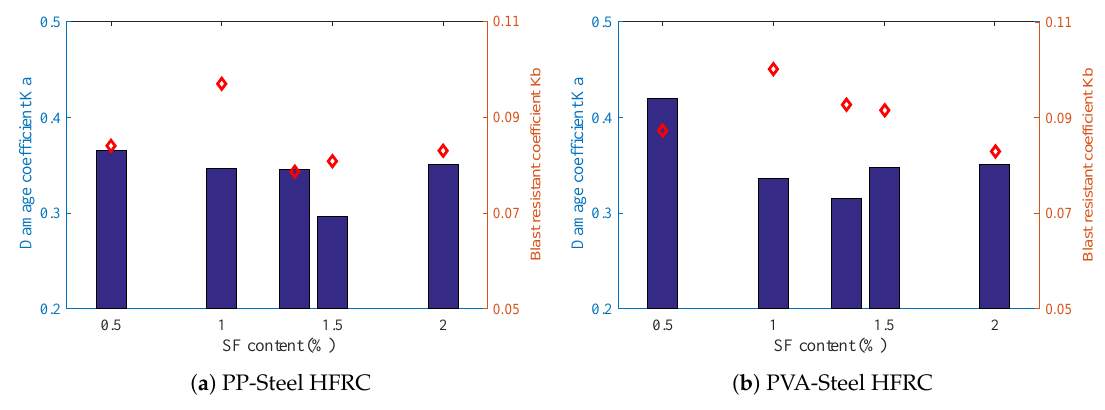
Figure 14. Damage coefficient K a and blast-resistant coefficient K b .